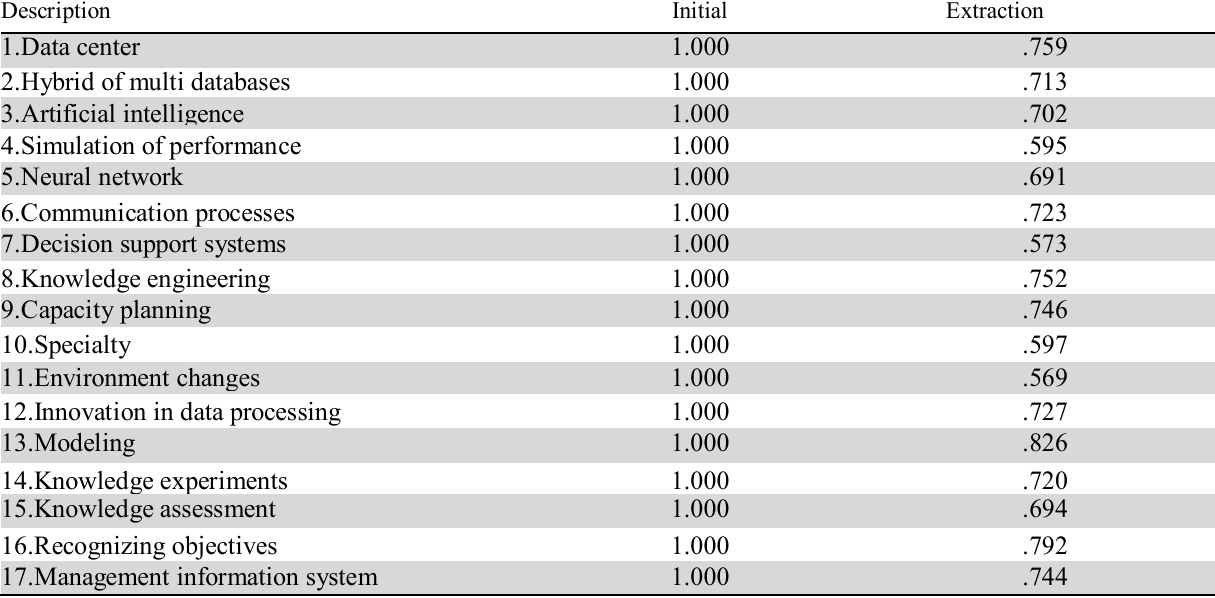
The results of communalities based Principal Component Analysis Description Initial